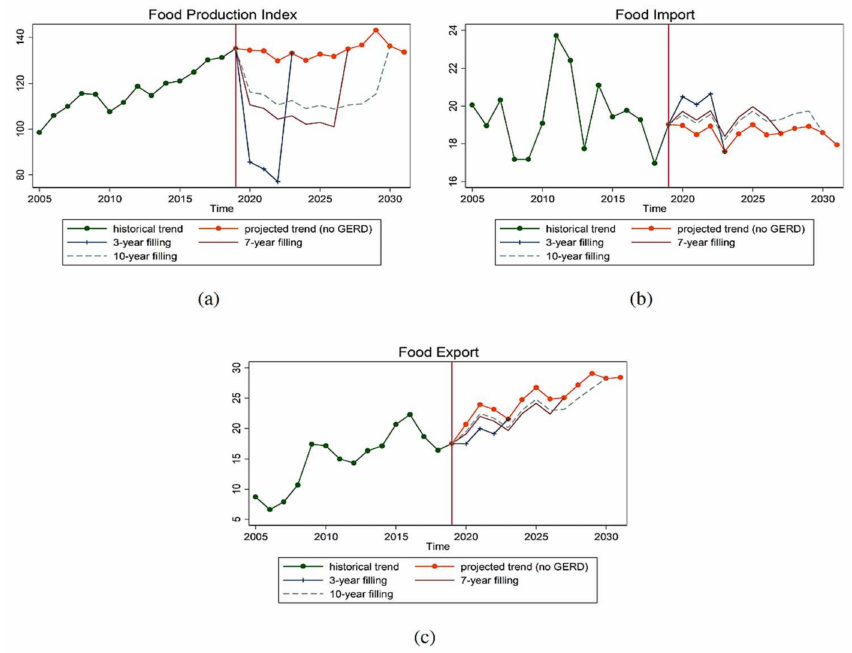
Figure 6. Projected trends in ( a ) food production index, ( b ) food imports, and ( c ) food exports under the alternative filling